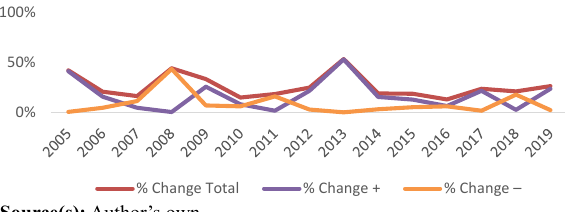
Figure 1. Changes in Shar (cid:1) ı ʿ ah- compliant constituents ’ weighting as a percent of total Shar (cid:1) ı ʿ ah- compliant portfolio market capitalization as at previous year end